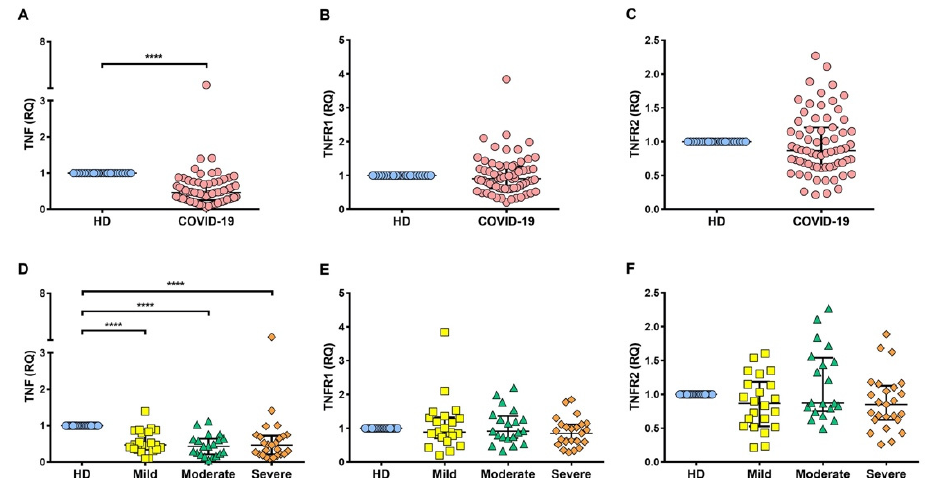
Figure 3. TNF, TNFR1, and TNFR2 are not increased at the transcriptional level in COVID-19 patients. The relative quantification (RQ) of TNF, TNFR1, and TNFR2 transcripts was evaluated by qRT-PCR in PBMCs of healthy donors (HD) and COVID-19 patients. A comparison between HD and COVID-19 provides evidence that for TNF, TNFR1, and TNFR2, the RQ was not increased in COVID-19 patients ( A – C , respectively). There was a significant difference in the decrement in TNF. Between COVID-19 groups (mild, moderate, and severe) ( D ), regarding receptors there were no differences ( E , F ). The Ct values for each gene were normalized to the endogenous control gene 18S rRNA, and the relative expression of transcripts was quantified by the ∆∆ CT method. Data are presented as median with interquartile range (HD n = 10, mild n = 22, moderate n = 21, and severe n = 25). **** p < 0.0001.